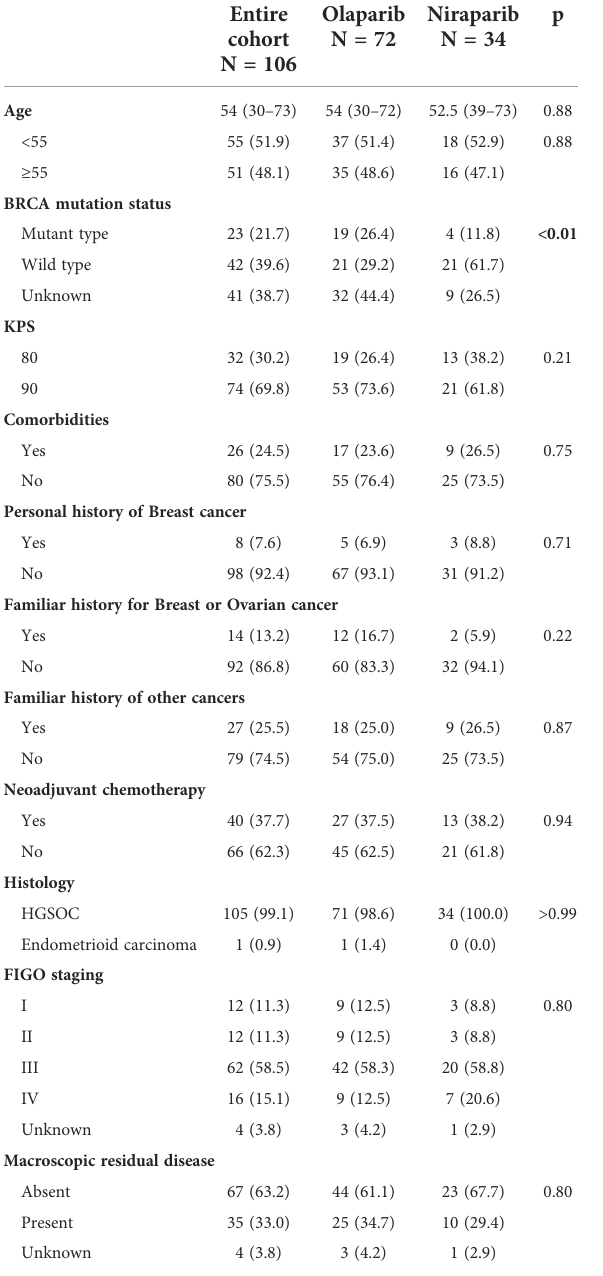
TABLE 1 Characteristics of patients at diagnosis of ovarian cancer. TABLE 2 Characteristics of patients at time of PARP inhibitors